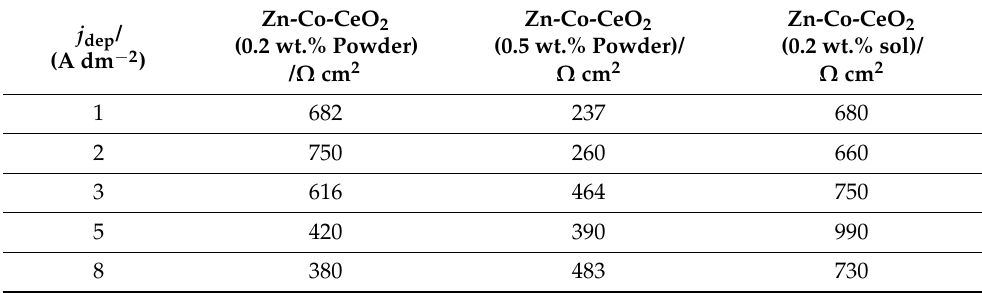
Table 1. Polarization resistance values of composite coatings deposited from solutions containing ceria powder (0.2 wt.% and 0.5 wt.%) and ceria sol (0.2 wt.%) under magnetic